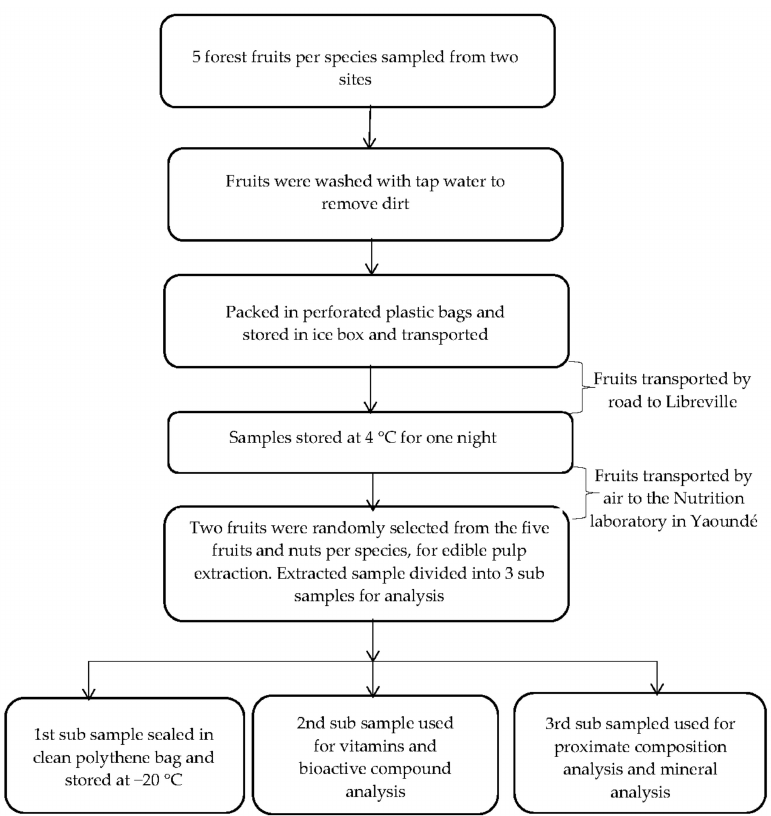
Figure 3. A schematic representation of the sampling of edible parts of fruits and nuts in the field and in the